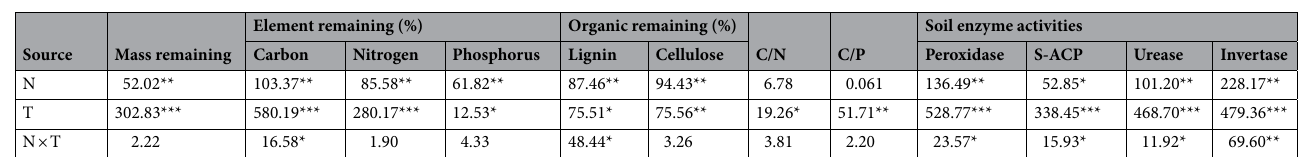
Table 3. Results (F-value) of repeated measures ANOVA of the effects of N deposition, time, and their interactions on mass remaining, elements remaining, organic material remaining, C/N and C/P ratios, and soil enzyme activity during leaf litter decomposition. N nitrogen deposition; T decomposition time (month); N × T interactions of nitrogen and time. Values of probabilities ( P ) for repeated measures ANOVA in bold are significant ( P < 0.05. *, P < 0.05; **, P < 0.01, ***, P < 0.001). S-ACP: Acid